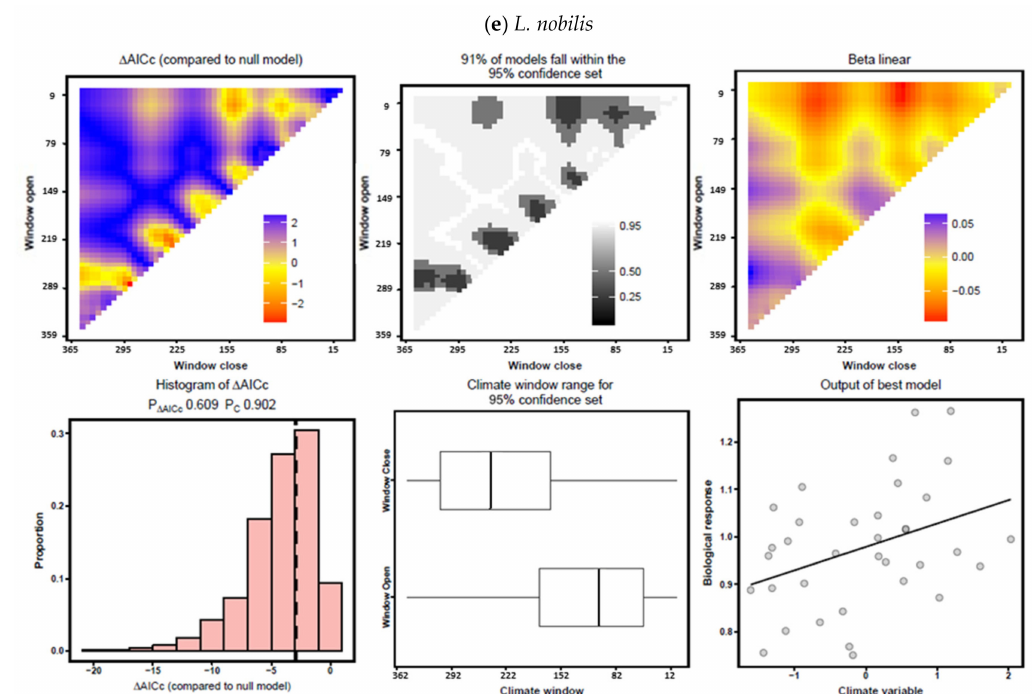
Figure 7. “ Climwin ” analyses showing associations between growth variability and the SPEI drought index. The plots correspond to the selected SPEI monthly values based on the models showing the highest R 2 and lowest ∆ AICc values (see Table 4): 9-month SPEI values in the case of P. terebinthus ( a ), P. lentiscus ( b ), and C. australis ( d ), and 1-month SPEI values in the case of A. unedo ( c ) and L. nobilis ( e ). Windows open and close values are the Julian day of the year